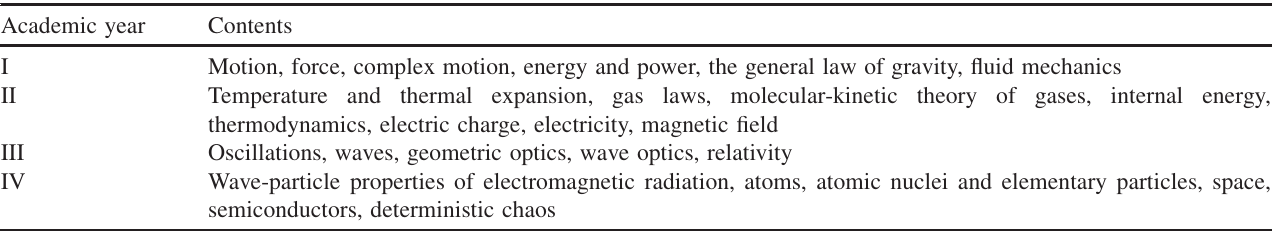
TABLE II. Physics high school program in grammar and modern languages.